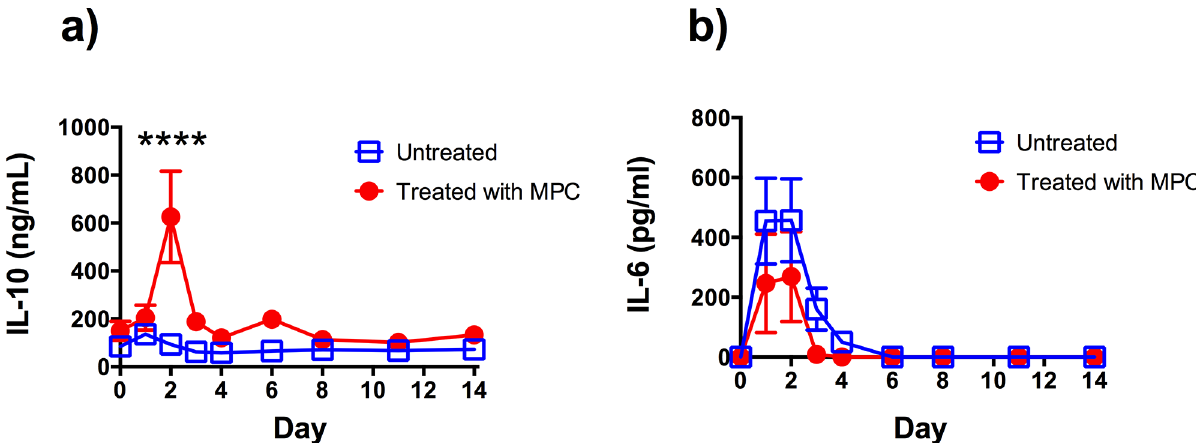
Fig 1. Comparison of plasma concentrations of (A) IL-10 and (B) IL-6 measured over time in arthritic sheep treated and untreated with mesenchymal precursor cells (MPC). Each point represents the mean ± SEM of 7 – 8 sheep. **** Indicates a statistically significant difference between groups at that time point, p (cid:1)